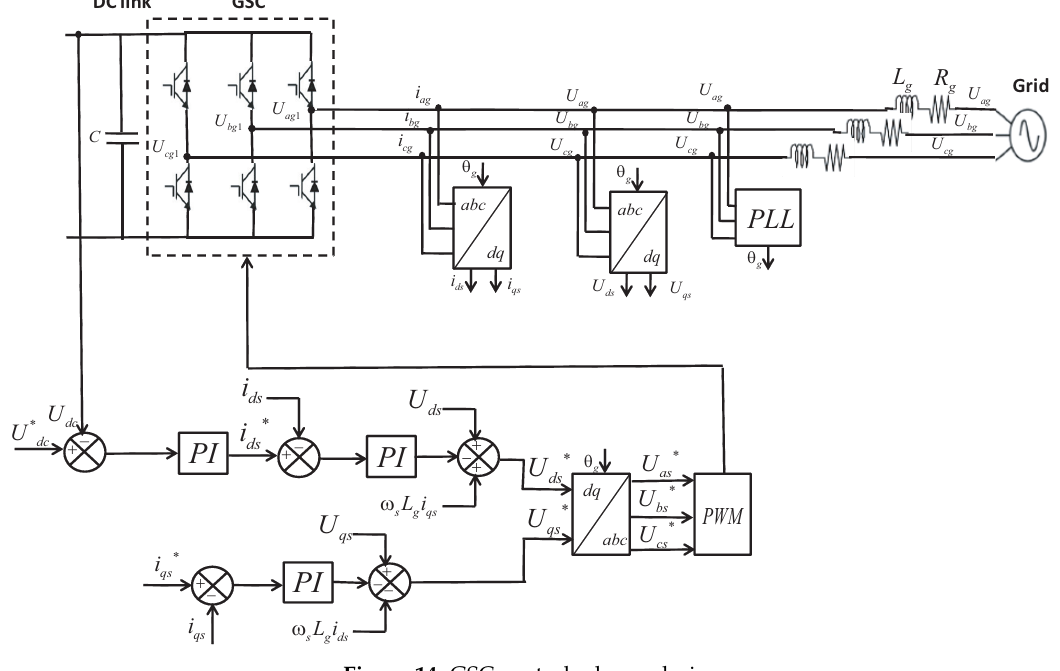
Figure 14. GSC control scheme